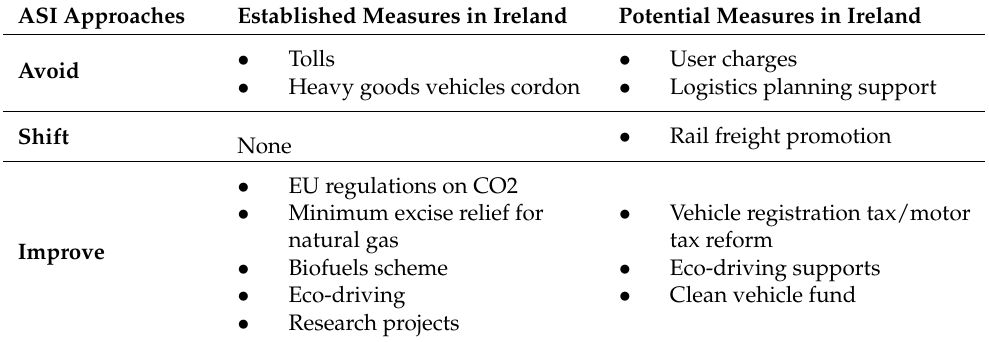
Table 2. Established and Potential Policy Measures for Decarbonisation in Irish Freight Transport